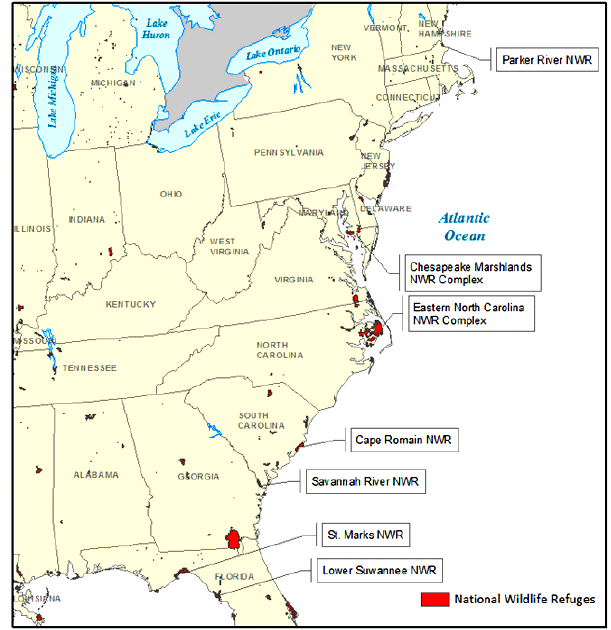
Fig. 1 . Map of eastern National Wildlife Refuges